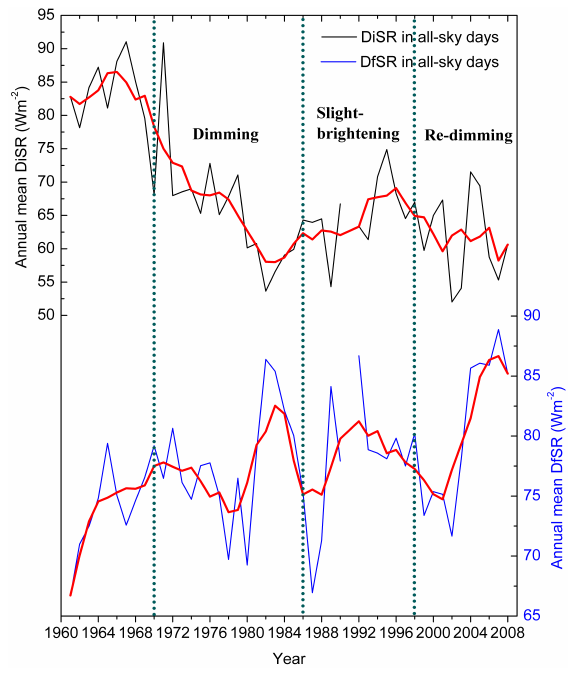
Fig. 2. Same as Fig. 1, but for all-sky